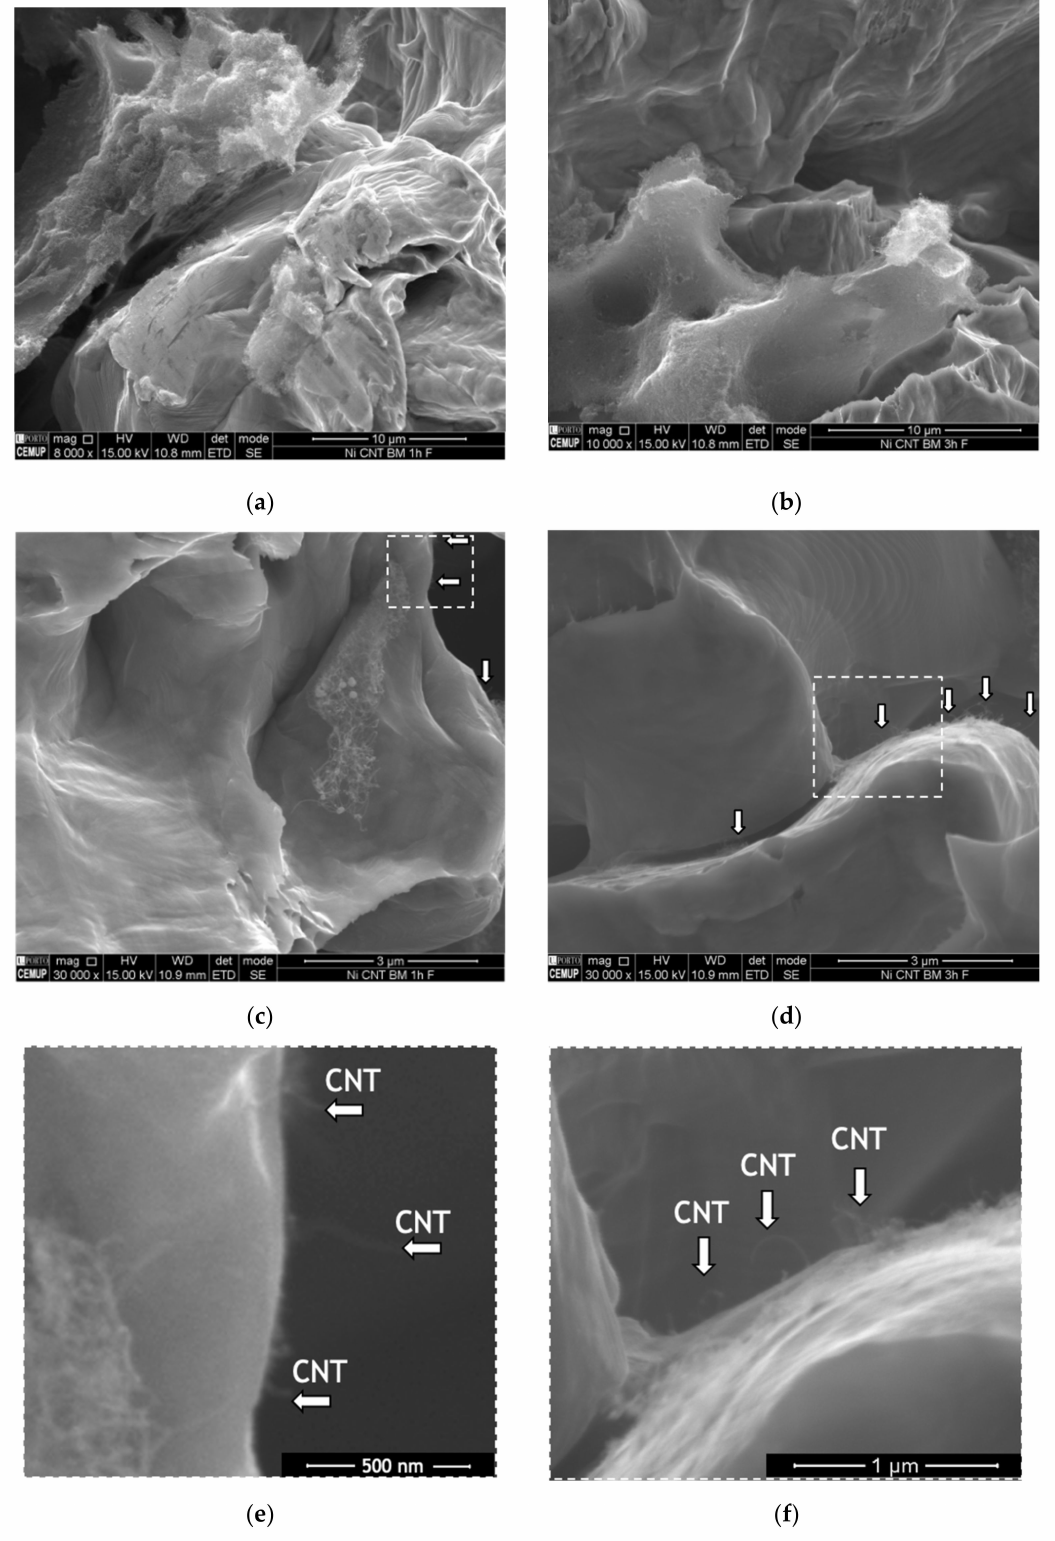
Figure 3. Scanning electron microscopy (SEM) images of the fracture surface of the nanocomposites produced using ball milling for ( a , c , e ) 60 min; and ( b , d , f ) 180